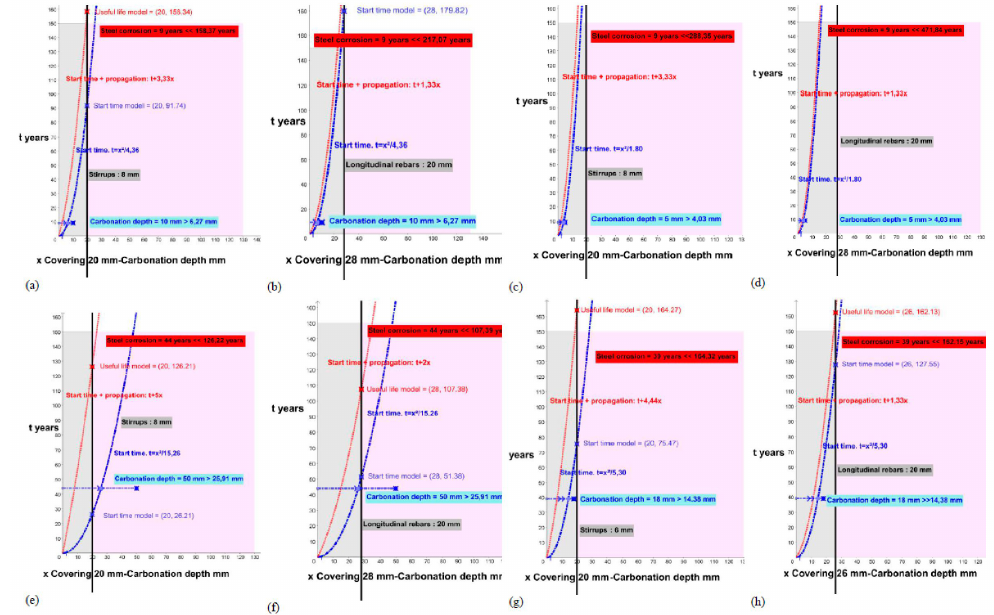
Figure 10. Start and propagation corrosion times in building 8A, 9M and 10E. ( a ) 8A_P1_ Stirrups. ( b ) 8A_P1_ longitudinal rebars. ( c ) 8A_P21_ Stirrups. ( d ) 8A_P21_longitudinal rebars. ( e ) 9M_P1_ Stirrups. ( f ) 9M_P1_ longitudinal rebars. ( g ) 10E_P11_Stirrups. ( h ) 10E_P11_longitudinal